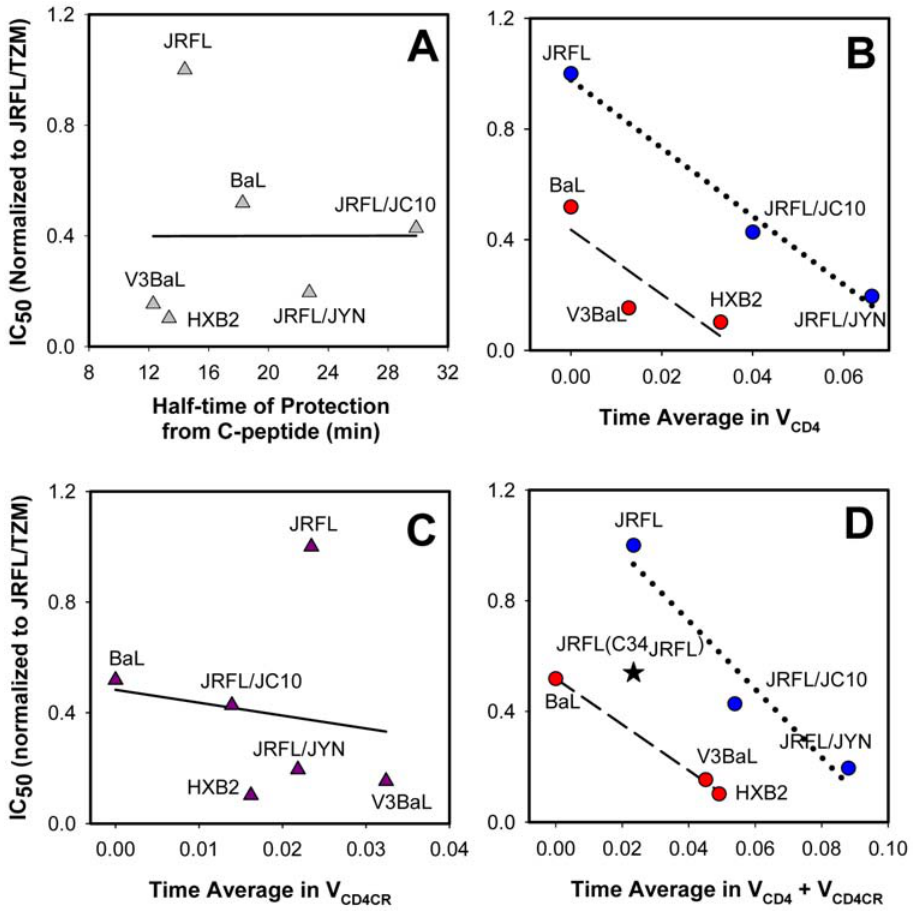
Figure 6. Correlation between the potency of C34 and the time average of HIV-1 in intermediate states. (A) Relationship between the C34 IC 50 (normalized to that of JRFL on TZM-bl cells) and the kinetics of escape from a high concentration of C52L parameterized as the time at which half of the viruses acquire resistance to this peptide. Solid line is a linear regression. (B) The C34 IC 50 was normalized to that for the JRFL fusion with TZM-bl cells and plotted vs. the time average in the V CD4 state. Separate linear regressions are shown for JRFL fusion with different target cells (dotted line, r 2 =0.99) and for HXB2-BaL-V3BaL constructs fusing with TZM-bl cells (dashed line, r 2 =0.73). (C) Lack of correlation between the inhibitory activity of C34 and the lifetime of the V CD4CR state. (D) Correlation between the time averages in both intermediate stages (V CD4 plus V CD4CR ) and the potency of C34. Separate linear regressions are shown for BaL, HXB2 and V3BaL (dashed line, r 2 =1.00) and for JRFL fusion with different target cells (dotted line, r 2 =0.93). The IC 50 for the C34 JRFL against JRFL (star) is shown for comparison. Note that the more potent C34 JRFL peptide inhibited JRFL almost as efficiently as the C34 IIIB inhibited BaL (Table